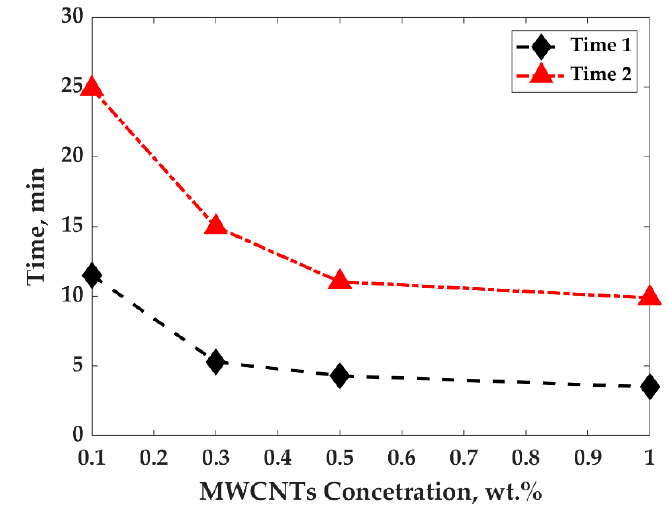
Figure 13. Time for complete crystallization of PP (Time 2) and time when electrical conductivity levels off (Time 1) as a function of MWCNTs concentration for PP/PS/MWCNTs composites.